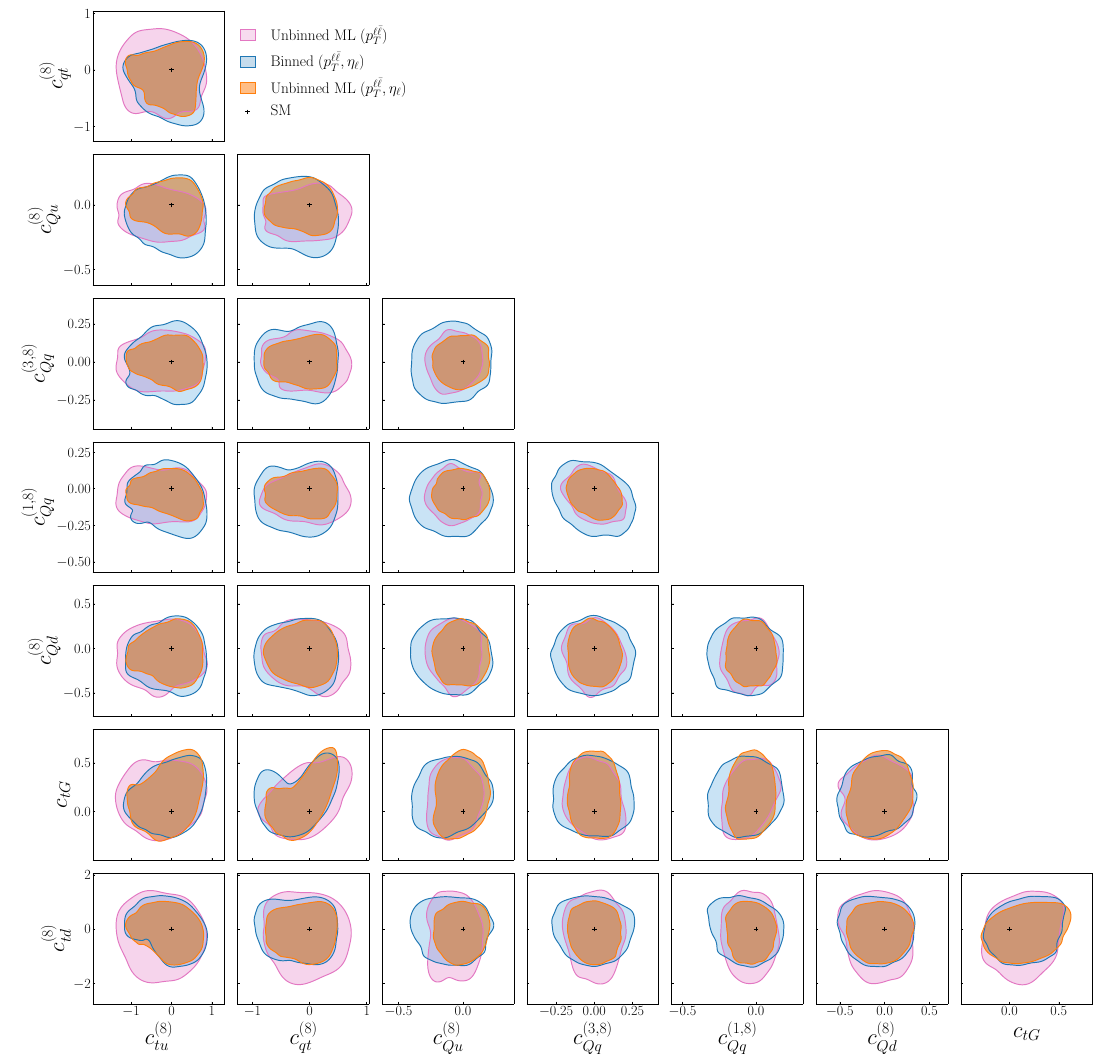
Figure 13. Same as figure 11 in the case of the EFT analysis carried out at the quadratic O (Λ − 4 ) level. We display the results for pair-wise contours obtained from the marginalization of the posterior distribution in the space of n eft = 8 Wilson coefficients. In comparison with the linear EFT analysis, it becomes possible to constrain three more coefficients from the same process once quadratic corrections are accounted for. We also include in this comparison the results obtained from the unbinned ML analysis based on p ‘ ¯ ‘ as the single input T